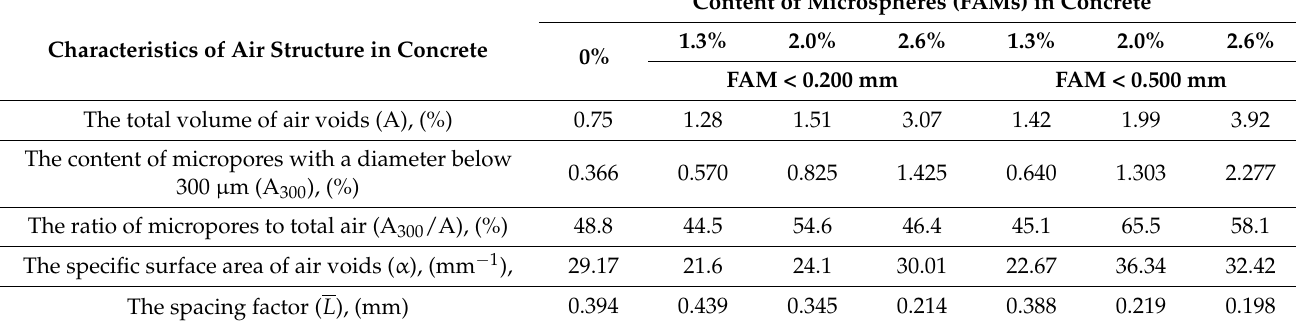
Table 5. The quantitative characteristics of air voids in hardened concrete prepared from CEM I 42.5R and three substitution rates of